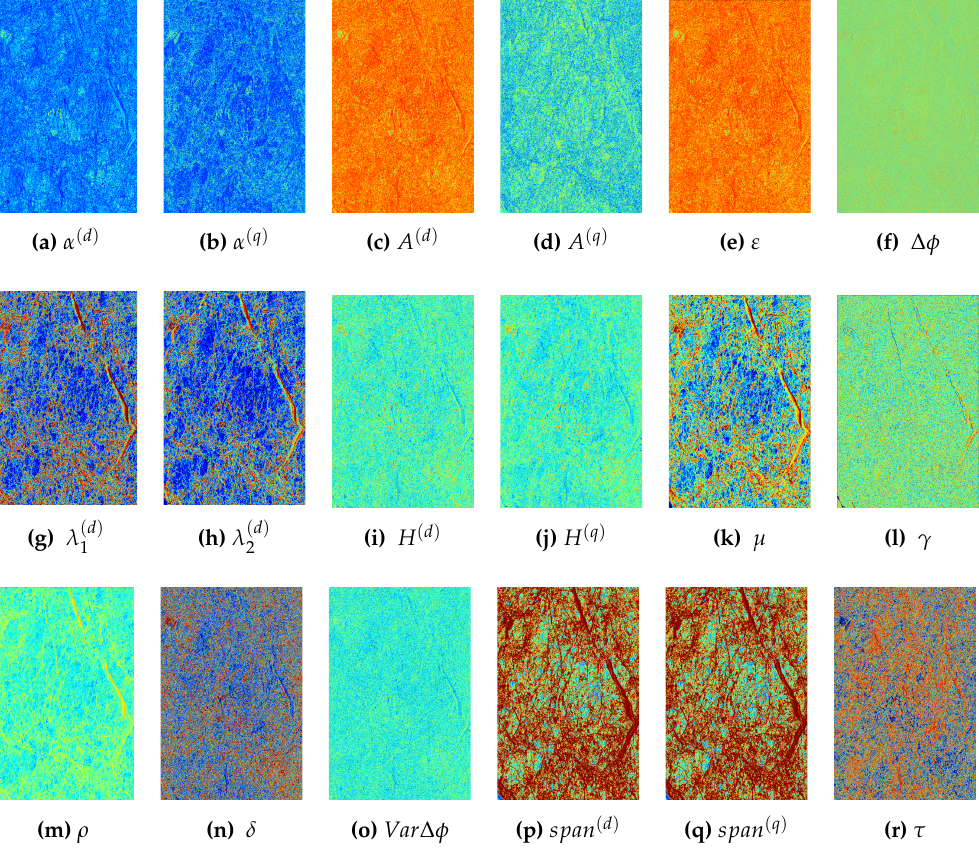
( d ) ( d ) ; ( h ) λ ; ( i ) H ( q ) ; ( j ) H ( q ) ; ( k ) µ ; ( l ) γ ; ( m ) ρ ; ( n ) δ ; ( o ) Var ∆ φ ; ( p ) span ( d ) ; 2 1